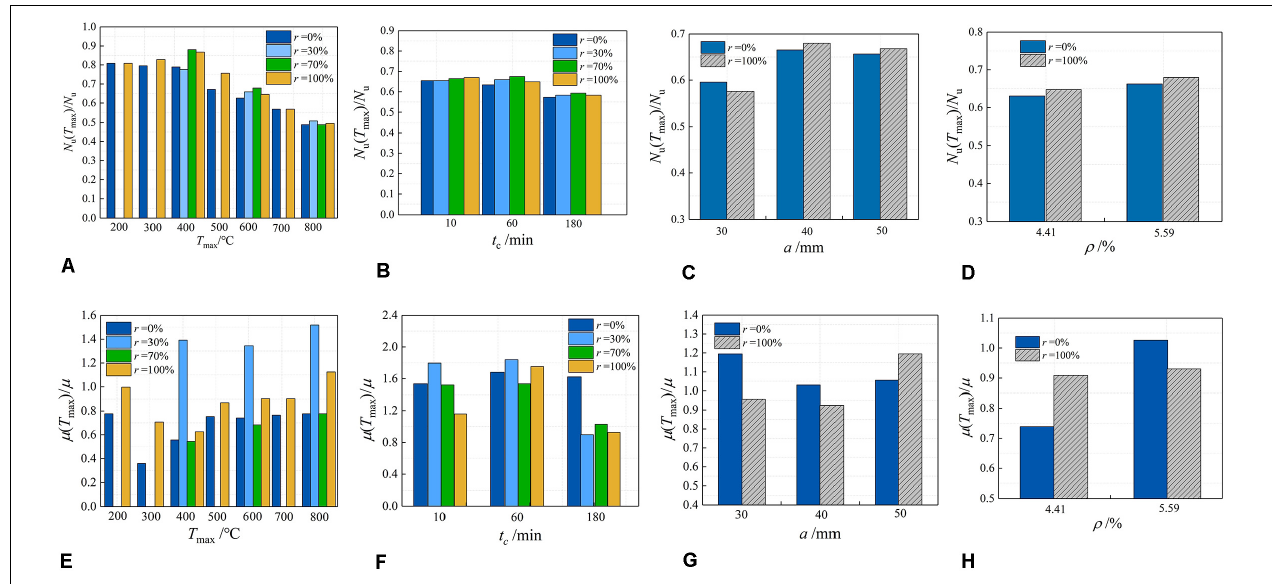
FIGURE 5 | Effect of the influencing factors on bearing capacity and ductility. (A) Effect of temperature on bearing capacity. (B) Effect of fire duration on bearing capacity. (C) Effect of cover concrete thickness on bearing capacity. (D) Effect of steel ratio on bearing capacity. (E) Effect of temperature on ductility. (F) Effect of fire duration on ductility. (G) Effect of cover thickness on ductility. (H) Effect of steel ratio on